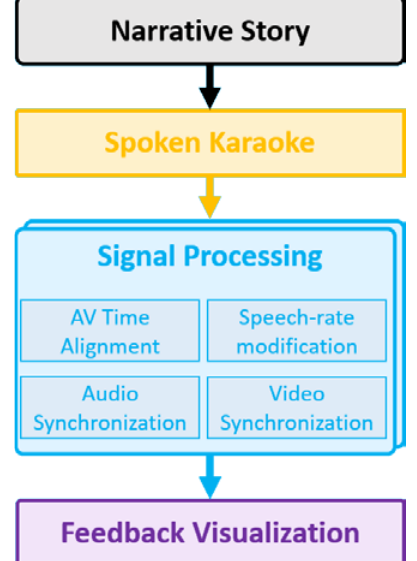
Figure 1 | Overview of the system and its